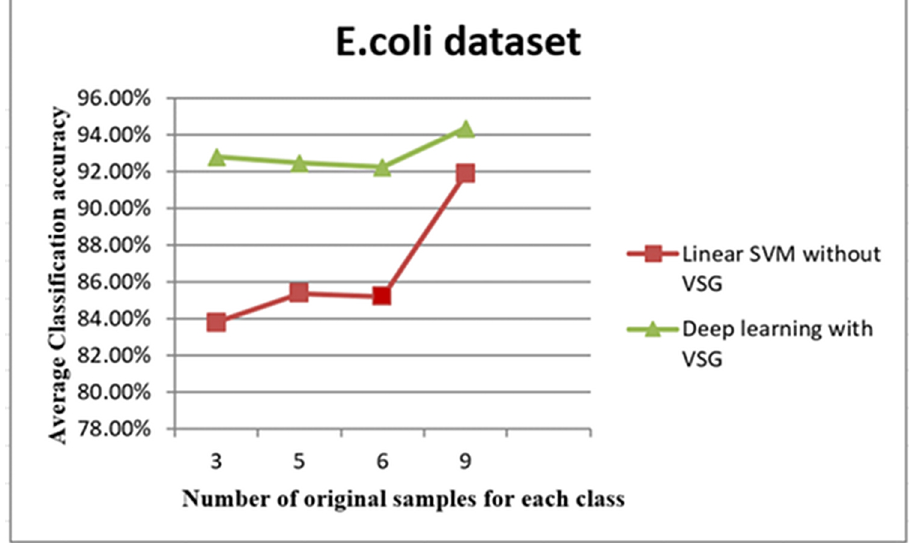
Figure 10. The trend of average accuracy using the E. coli dataset. The x -axis of this graph shows the original samples for each class that were used to generate the virtual sample in deep learning and the training sample for linear SVM, while the average of classification accuracy is the y